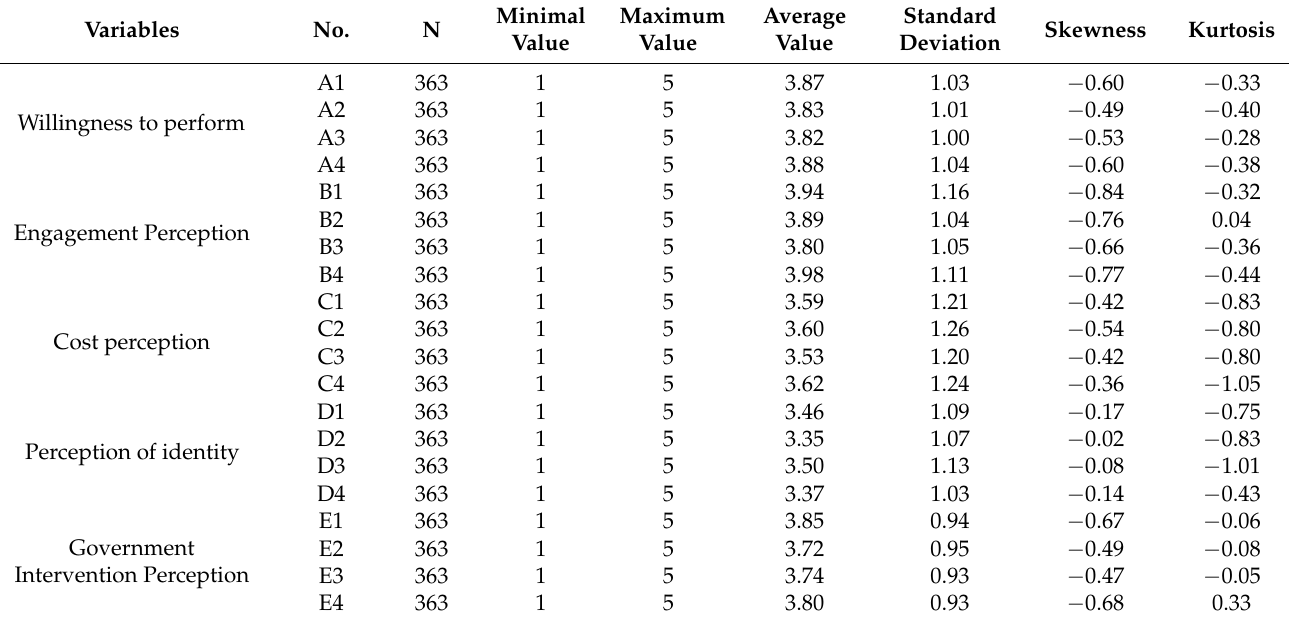
Table 3. Descriptive statistical analysis of the